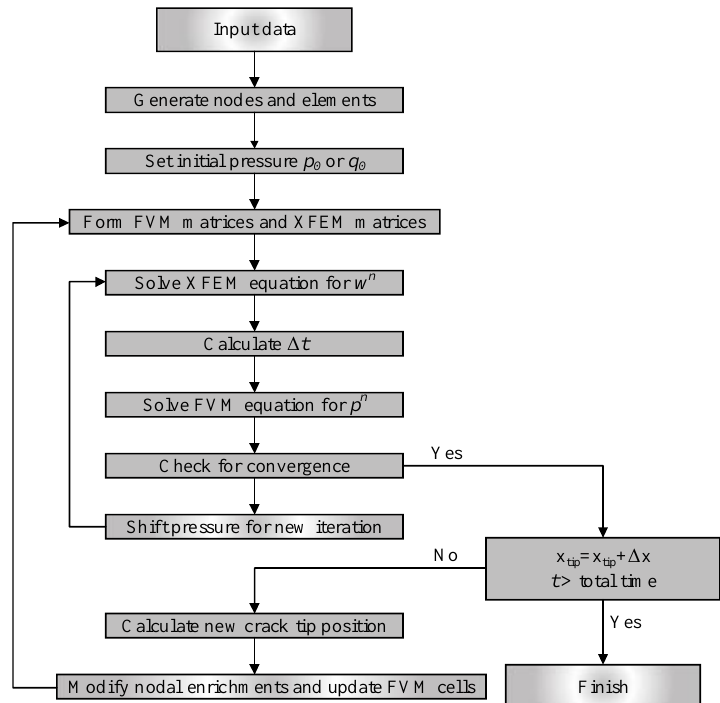
Figure 6. Flow chart of the finite volume and extended finite element method (FVM-XFEM) method.